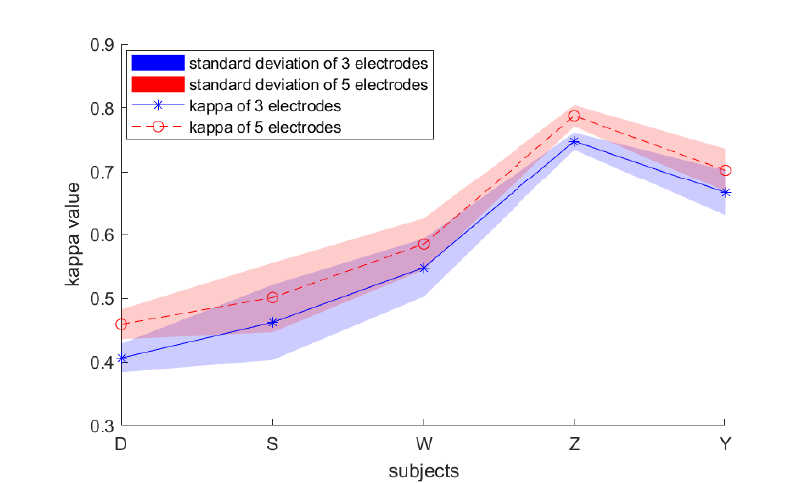
Figure 11. Kappa value and standard deviation results of our own dataset with 3 electrodes and 5